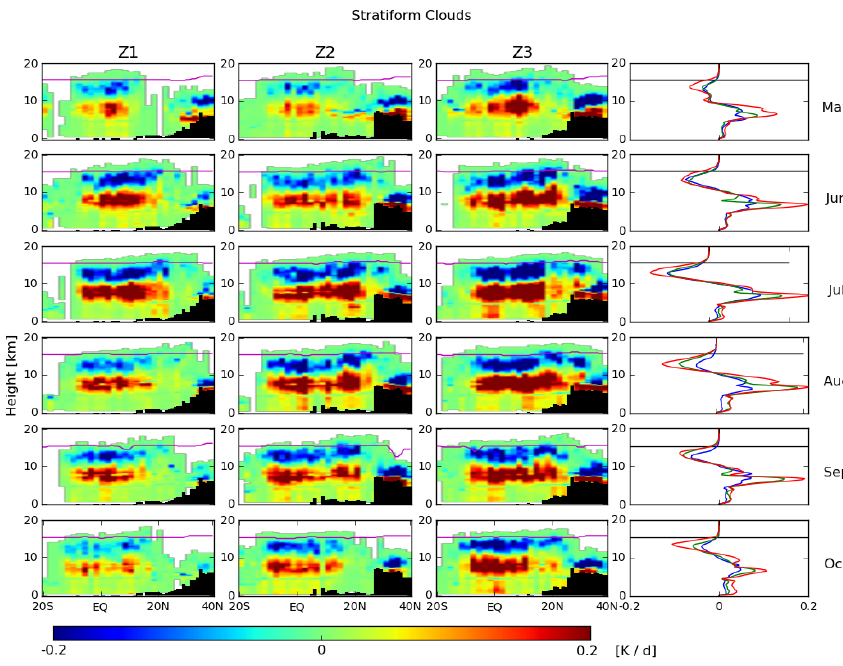
Figure 9. The monthly evolution of CRH due to alto- and nimbostratus